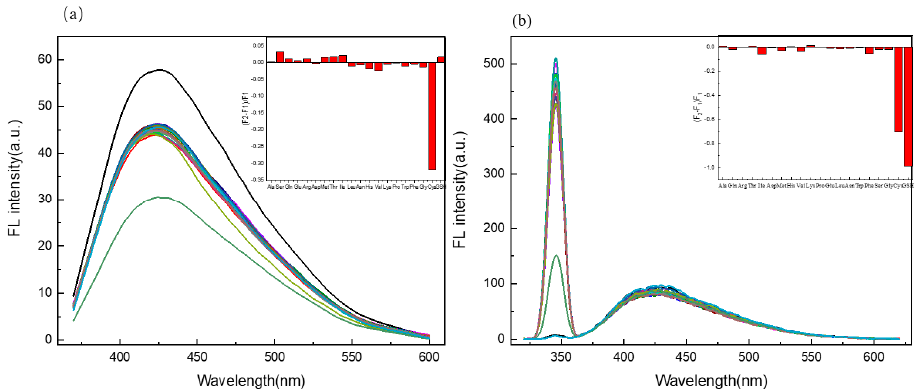
Figure 6. ( a ) The selectivity of the C/N-dots–Ag + complex system to different AA (100 μ M), the insets show (F 2 -F 1 /F 1 ) of the C/N-dots–Ag + complex system with the addition of different AAs; ( b ) The selectivity of RLS to the C/N-dots–Ag + system with the addition of various kinds of AA (100 μ M), F 2 and F 1 refer to the intensity of the C/N-dots–Ag + complex system with and without AAs (100 μ M), respectively.